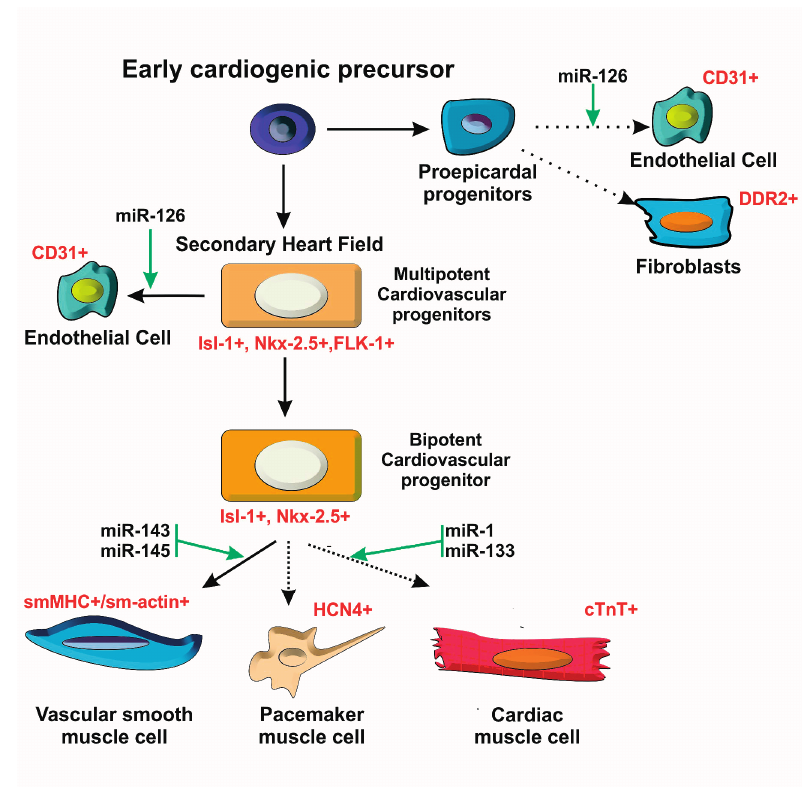
Figure 1. A stem cell model for heart development. The heart is composed of different cell types that are generated from multipotent cardiac progenitors. Expression of the LIM-homeodomain transcription factor Islet-1 (Isl-1+) is a hallmark of these cardiac progenitors. The diversification of heart cell lineages is acknowledged to be controlled by several